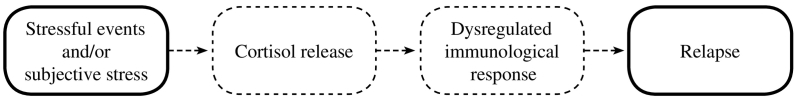
Proposed mechanisms through which stressful life events and/or subjective stress may lead to the occurrence of relapse in SSNS.